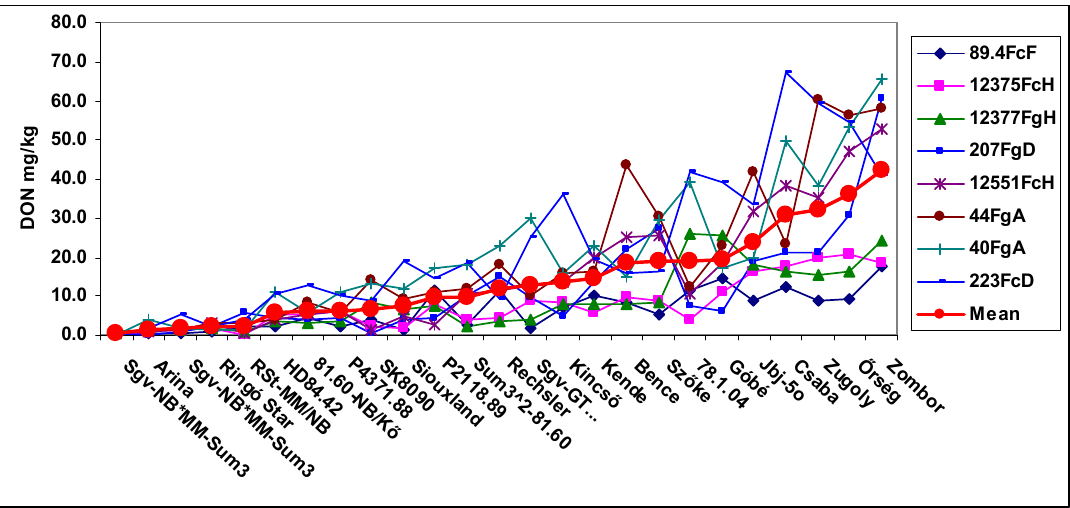
Figure 3. Resistance of winter wheat lines and cultivars to F. graminearum and F. culmorum isolates, 1994–1996. Deoxynivalenol (DON) contamination, mg / kg [34]. Larger variations in surveying of the susceptible cultivars could suggest that the disease development is more variable in susceptible cultivars due to a mixture of factors including the genotypes. The most resistant ones have high stability and low variation.